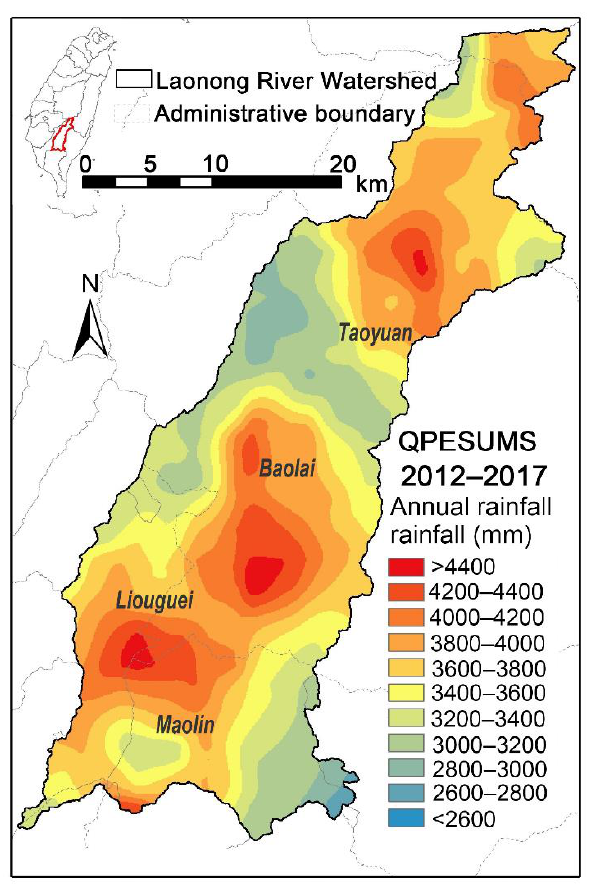
Figure 5. Spatial distribution of mean annual rainfall in 2012–2017 in the Laonong River watershed.